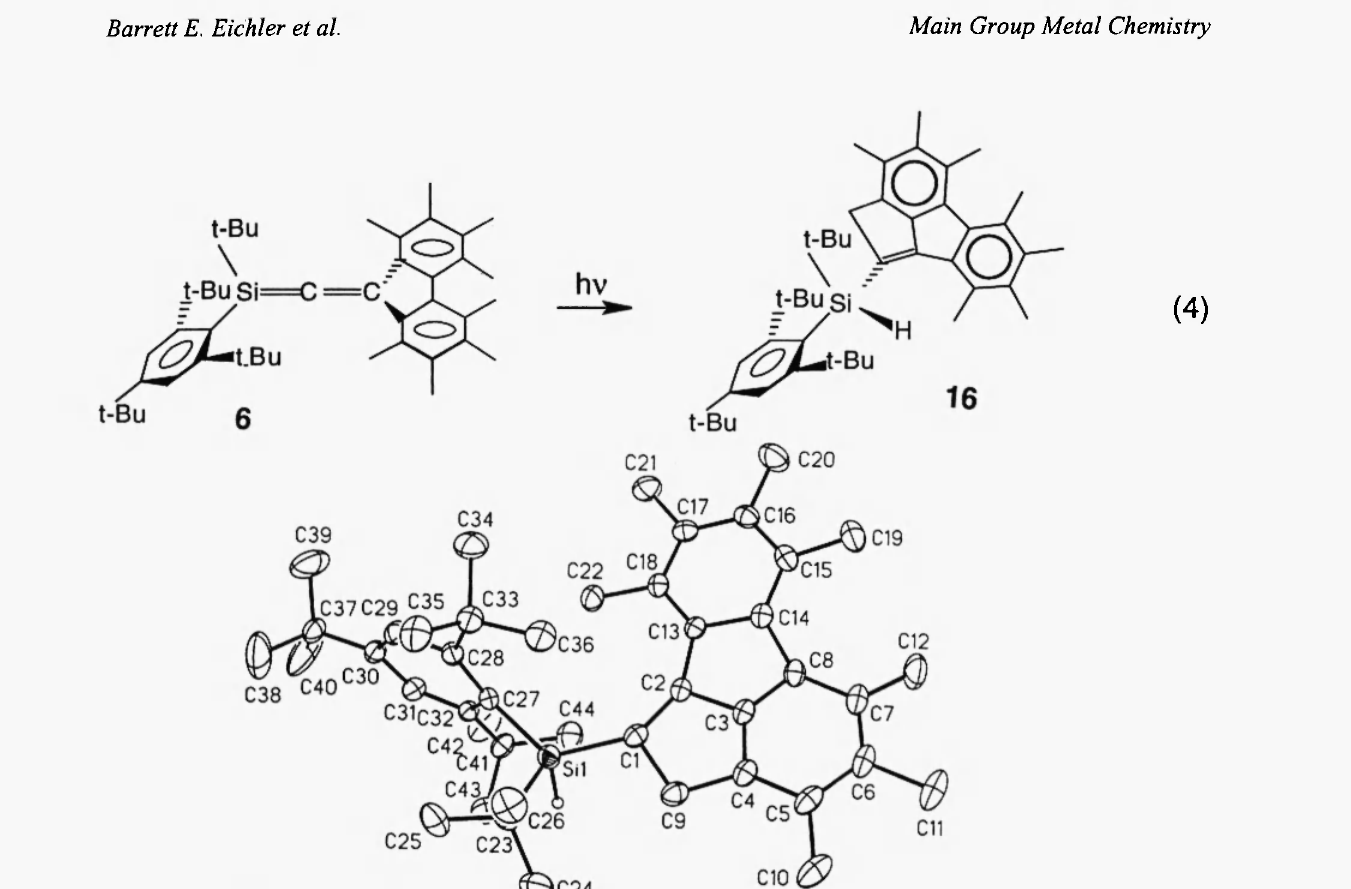
Figure 2. Thermal Ellipsoid diagram for 16. Significant bond lengths: Si-C1, 189.0(4); C1-C2, 138.6(5); C2-C3, 1143.9(5); C3-C4, 1136.2(5); C4-C9, 149.8(6); C1-C9, 156.4(5); C3-C8, 136.9(5); C2-C13, 150.1(5). -26.2 ppm. Silaallene 7 was synthesized by treating 17 with 2.2 equiv of t-butyllithium at -78 °C in diethyl ether and allowing the mixture to warm to room temperature overnight (eq 6). Compound 7 did not provide crystals suitable for X-ray crystallographic